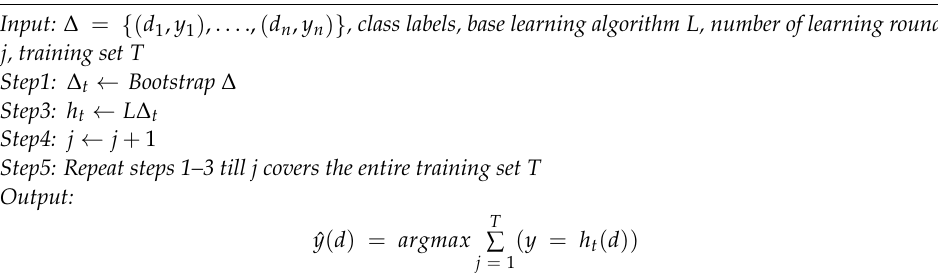
Algorithm 4: FHR Classsification using Bagging